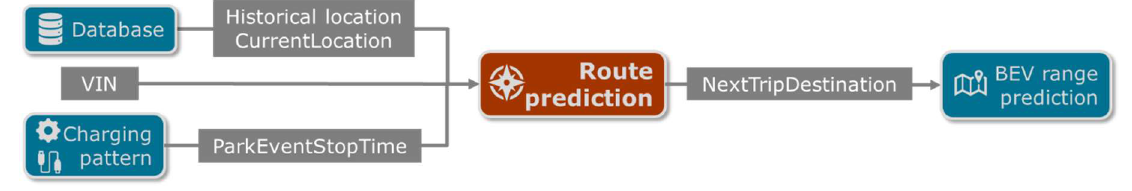
Figure 6. Route prediction algorithm interaction.